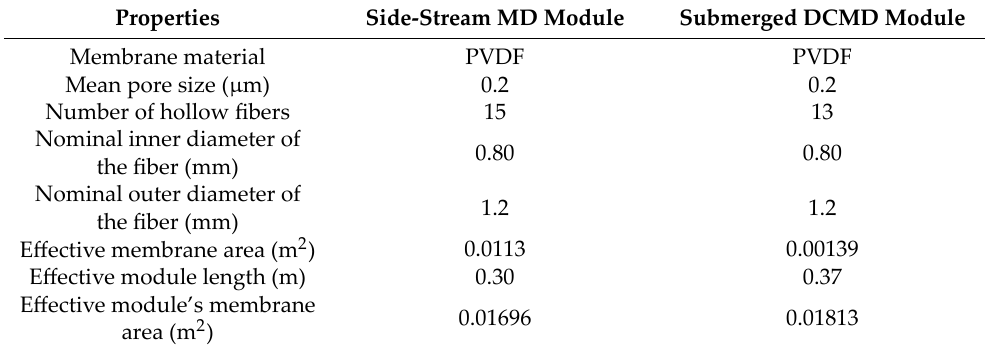
Table 2. Properties of MD modules used in the study.